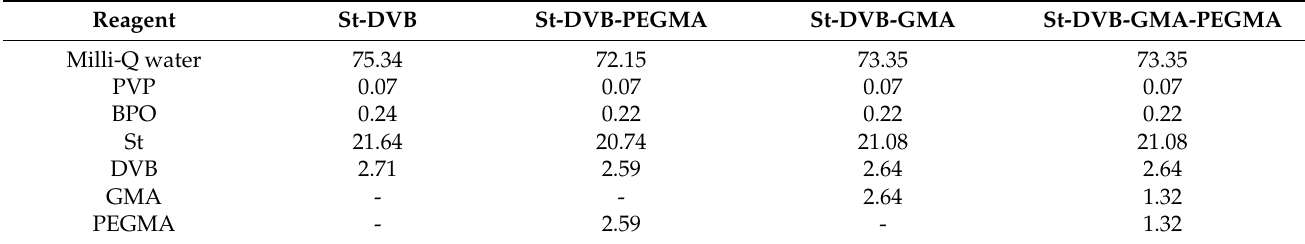
Table 1. Reaction recipes for the synthesis of the St-DVB based